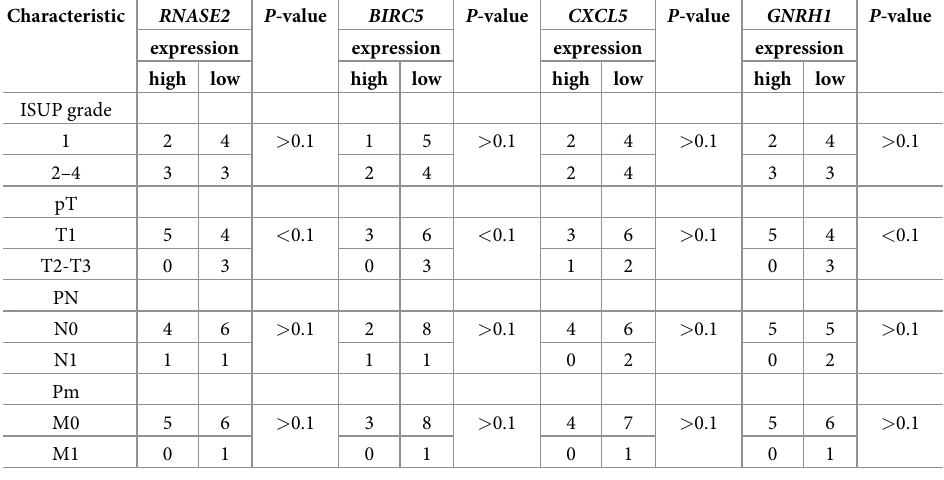
Table 3. Correlation between the expression levels of four hub genes and clinicopathology.